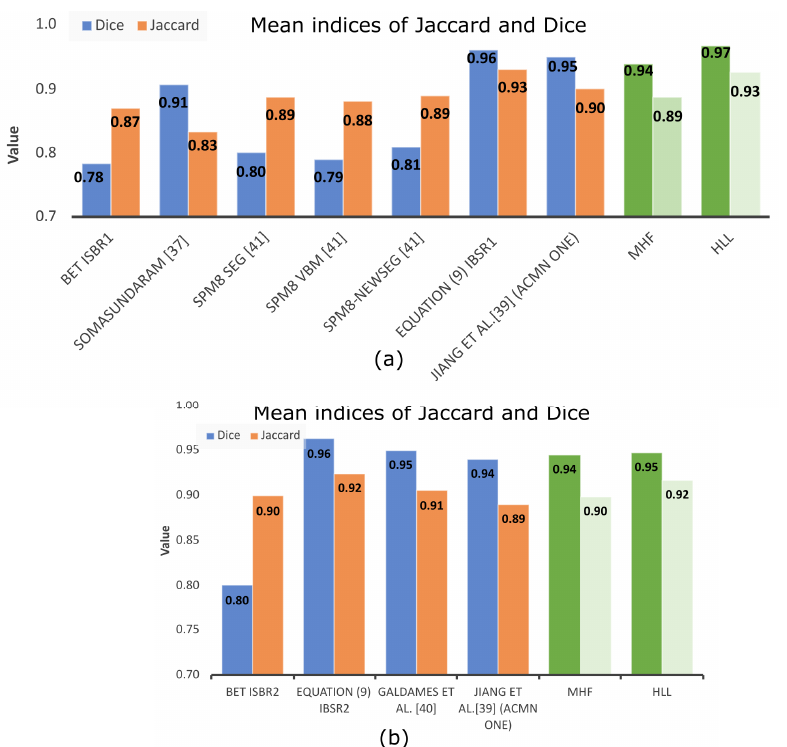
Figure 14. Indices comparison among the different methods reported in the current literature. ( a ) Indices of Jaccard and Dice for the methods displayed in Table 1 to the IBSR1 data set; ( b ) Indices of Jaccard and Dice for the methods displayed in Table 1 related to the IBSR2 data set.